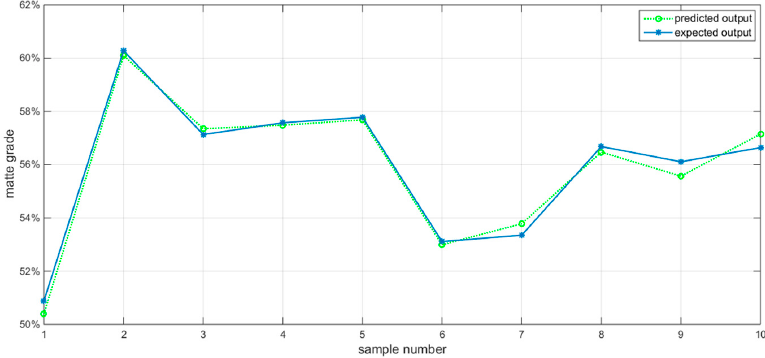
Figure 6. Matte-grade GA-BP neural network prediction model test result Figure 6. Ma tt e-grade GA-BP neural network prediction model test result graph. Table 3. GA-BP neural network prediction model simulation prediction data versus desired output data.